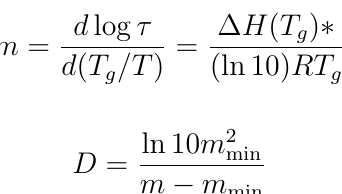
to obtain the activation enthalpy at T g